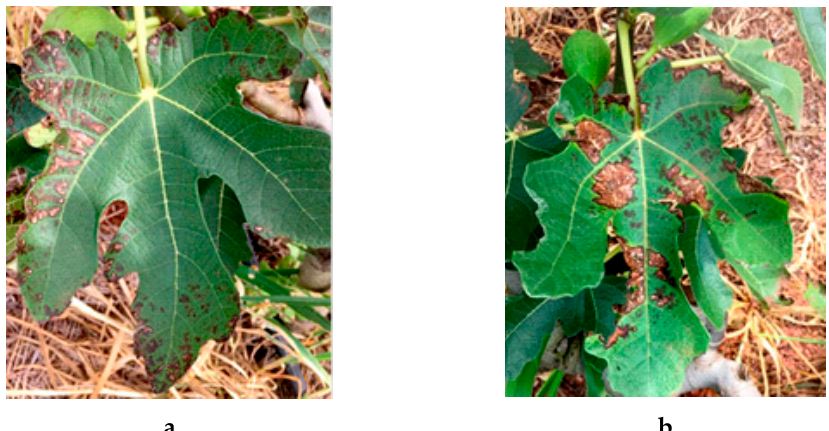
Figure 2. Symptoms of Ca 2+ toxicity in fig leaves cv. ‘Roxo de Valinhos’ as a function of pre-harvest CaCl 2 spray at 1.5% ( a ) and 2.0% ( b ).